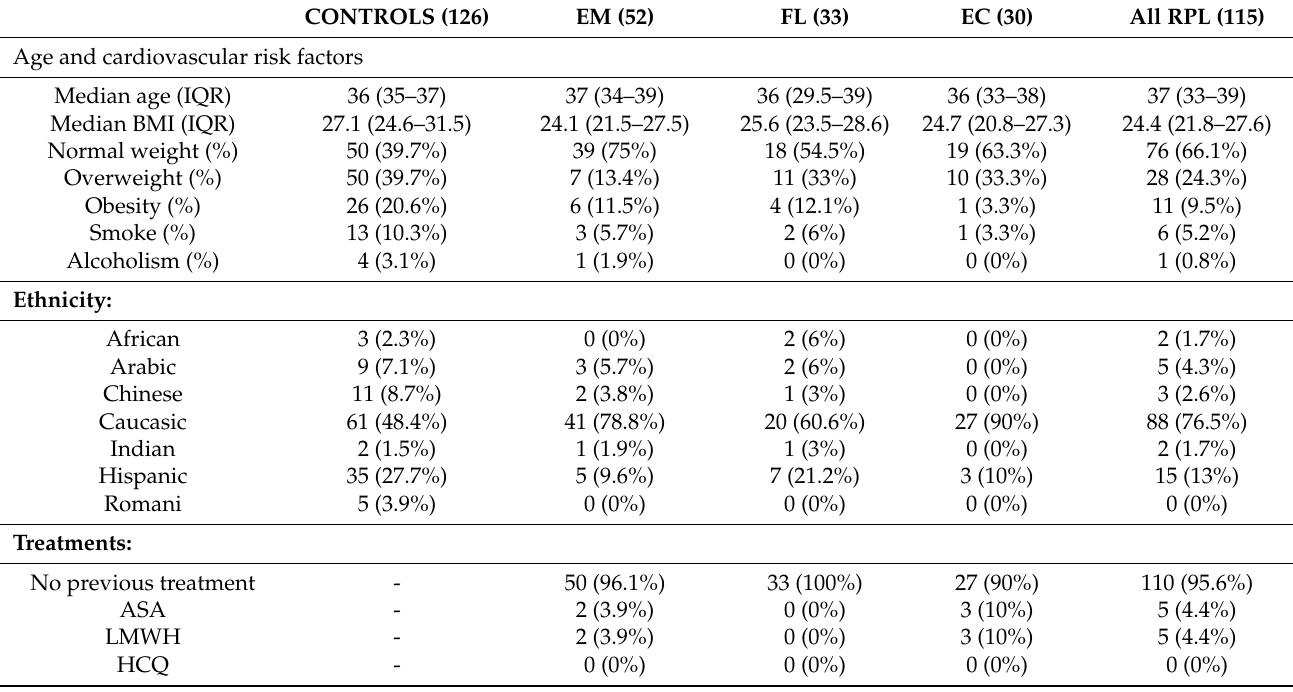
Table 1. Demographics, cardiovascular risk factors and previous treatments.